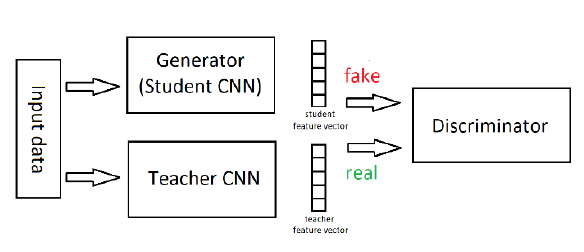
Figure 1. GAN for knowledge distilling.